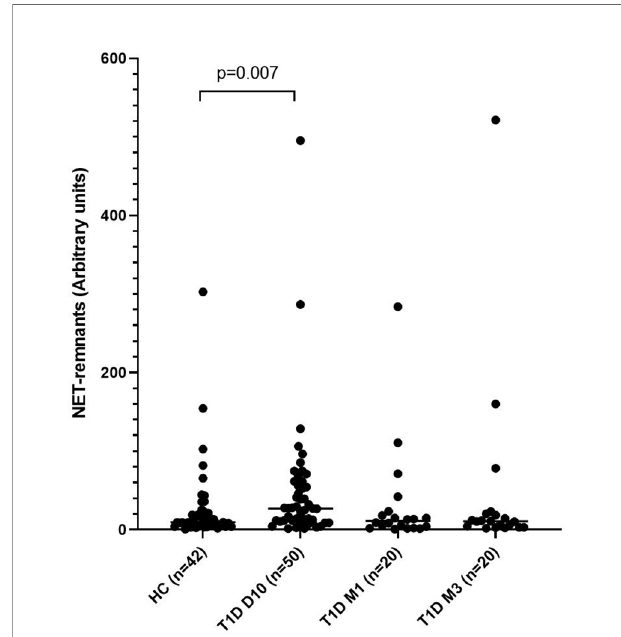
FIGURE 1 | Levels of NETs in children with newly diagnosed type 1 diabetes (T1D) and healthy children (HC). Healthy children (n=42) were compared with children after onset of T1D; 10 days (n=50), 1 month (n=20) and 3 months (n=20) after onset (cohort 1, Mann-Whitney